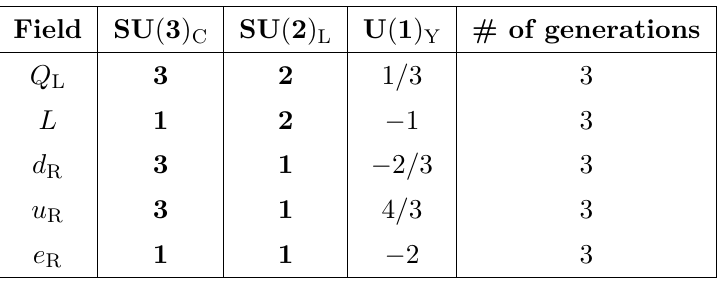
Table 1. SM-like sector for the fermions and quarks.